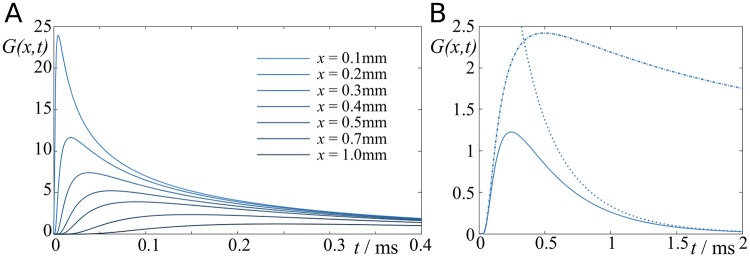
Green’s function of the cable equation.A: Green’s function for various distances x. B: Green’s function for x = 1mm, showing the slow (dotted) and fast (dash-dotted) approximation.